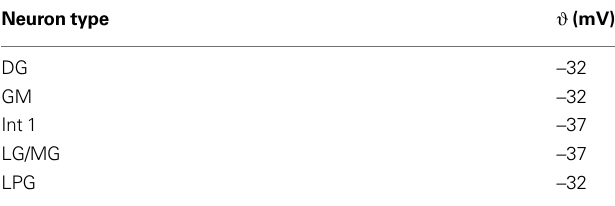
Table A2 | Inhibitory thresholds. Neuron type